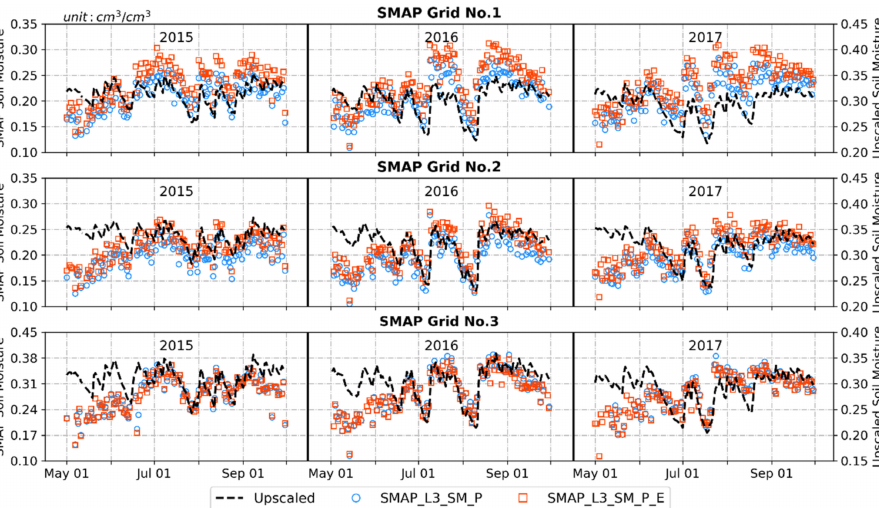
Figure 9. Temporal comparisons between the upscaled SM and SMAP products at the 36 km scale. Like SMAP, SMOS carrying sensors with the same observation band (L-band) have attracted increasing attention due to their better capacity to penetrate vegetation canopies. In the study area, as shown in Figure 10, the SMOS-L3 and SMOS-IC products did not yield similar skills to the SMAP, especially in terms of the R indexes, which showed low consistencies between the upscaled SM and SMOS products and had values of 0.310 for SMOS-IC and 0.128 for SMOS-L3. The SMOS products had a mean anomaly bias of 0.093 cm 3 cm − 3 represented by the ub RMSE index, which was approximately three times that of the SMAP products. The mean biases of the SMOS products, with -0.053 cm 3 cm − 3 for SMOS-IC and -0.004 cm 3 cm − 3 for SMOS-L3, were smaller than those of the SMAP products. The SMOS-IC product had a retrieval algorithm similar to that of SMOS- L3, but several simplifications, such as rejecting some ancillary data, were implemented. Compared with SMOS-L3, the accuracy of SMOS-IC on the RMSE index was not obviously improved. However, the averaged anomaly accuracies of SMOS-IC on the R and ub RMSE indexes were higher than those of SMOS-L3, and the R values still represented a weak